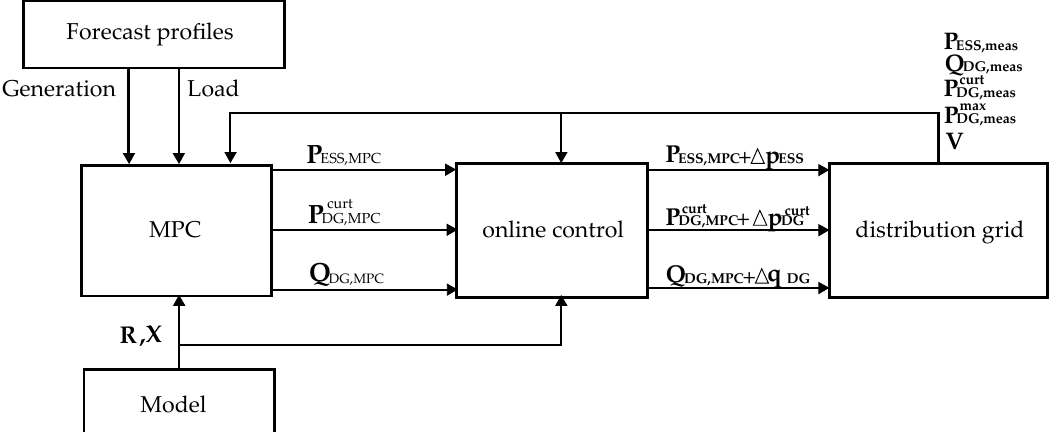
Figure 12. Control structure for Test 1.